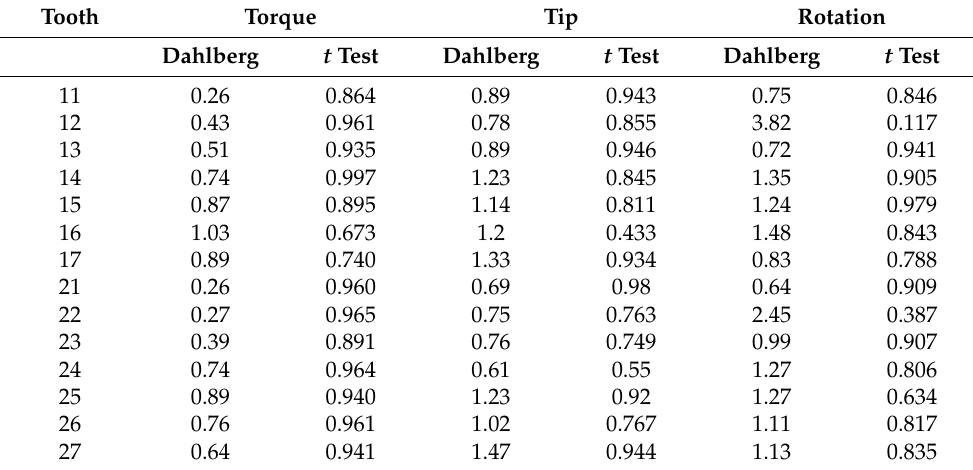
Table 1. Method of error and systematic error for the used analysis.